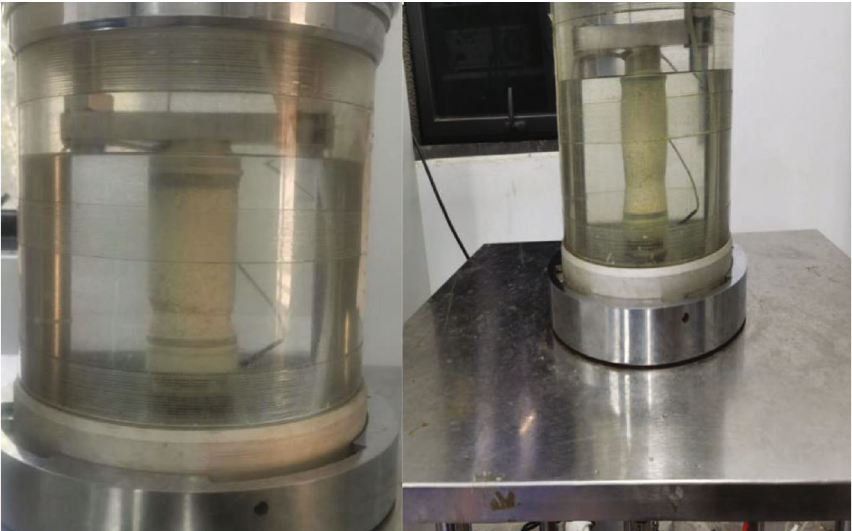
Figure 6: Sample diagram under di ff erent cyclic loads and 300kPa e ff ective con fi ning pressure.